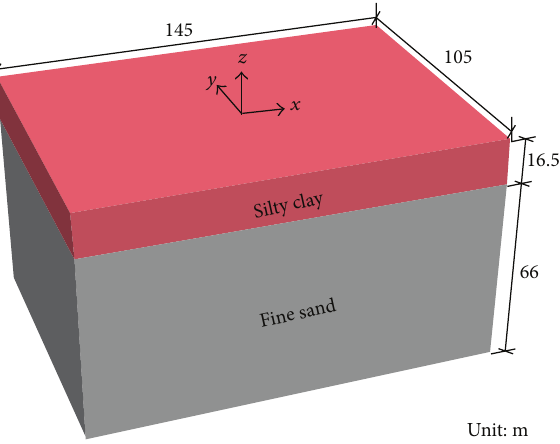
Figure 5: Soil layers distribution and computational boundary condition.